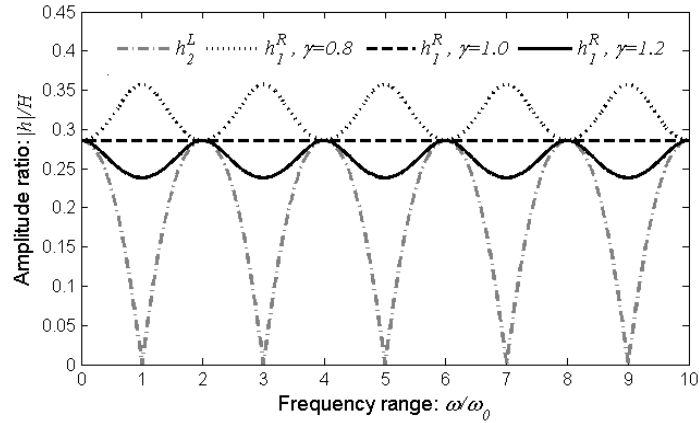
Figure 2. The frequency responses of a single pipe with the frictionless model at three valve signal intensity (VSI) conditions ( γ = 0.8, γ = 1.0, γ = 1.2).